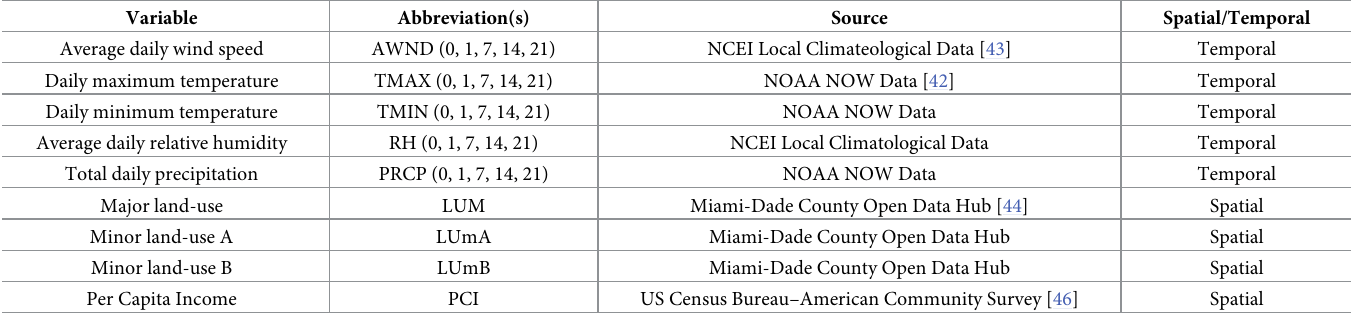
Table 1. Variable names, abbreviations, and sources for each explanatory variable. Each of these variables is used in random forest predictive models against Ae